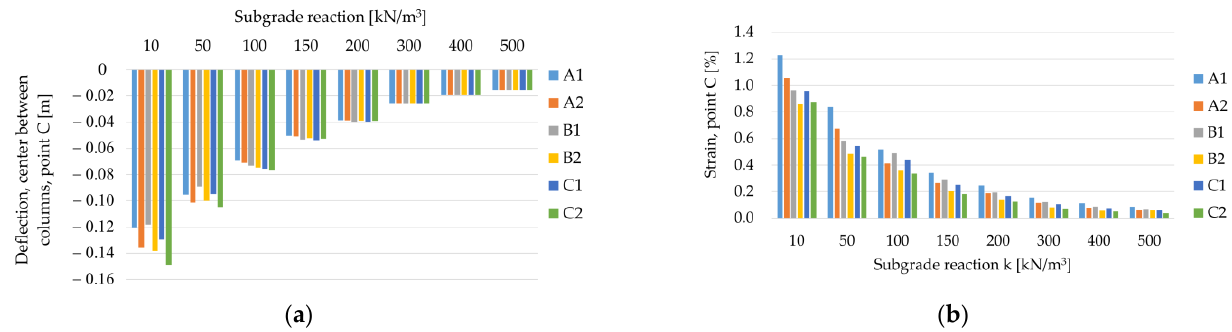
Figure 24. Membrane deflections and strain at point C depending on the subgrade reaction k and the geometric variant, J = 1615 kN/m: ( a ) deflection of the membrane at the point C; ( b ) strain at point C.